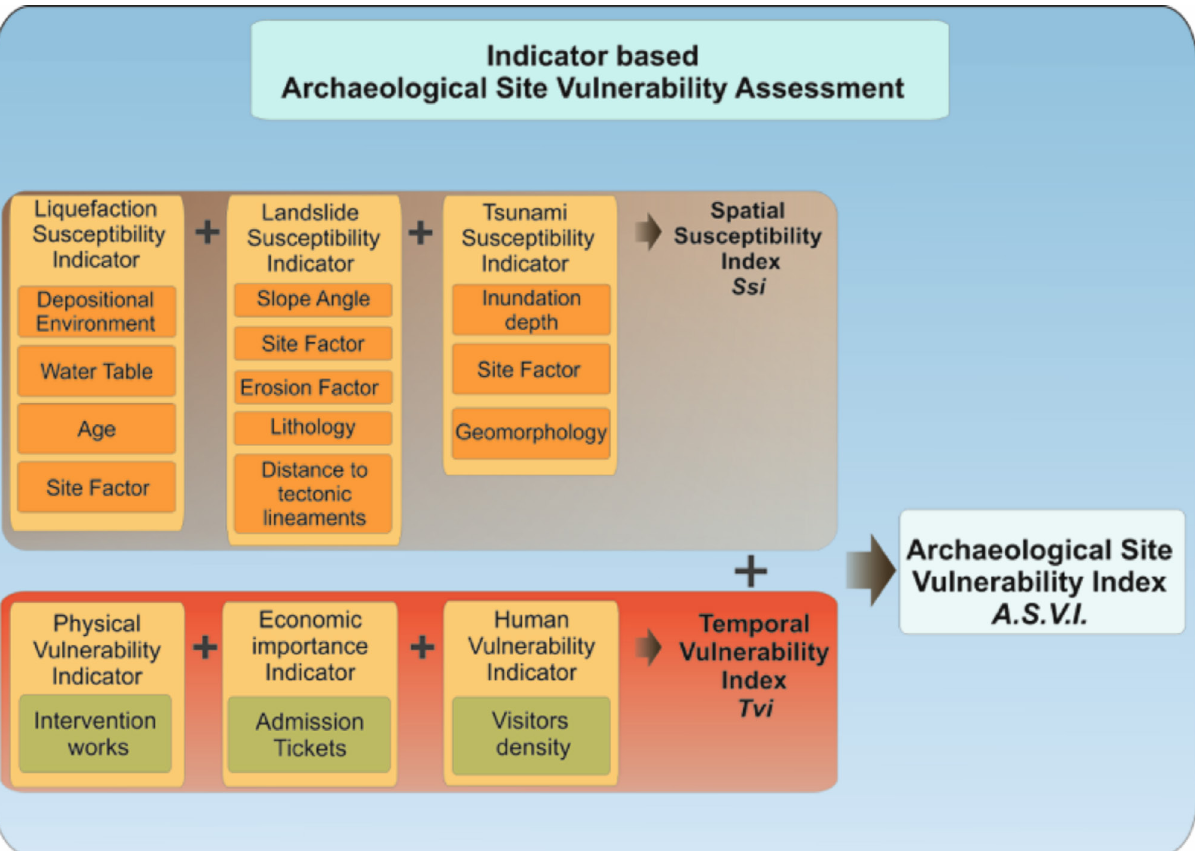
Figure 2. A schematic representation of the indicator based Archaeological Site Vulnerability